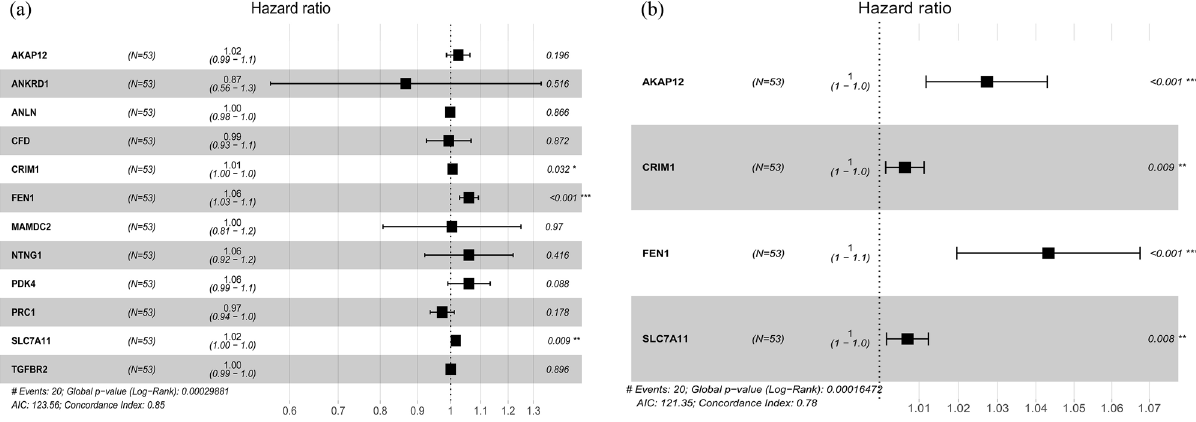
Figure 7: The risk prognostic model, included AKAP12, CRIM1, FEN1 and